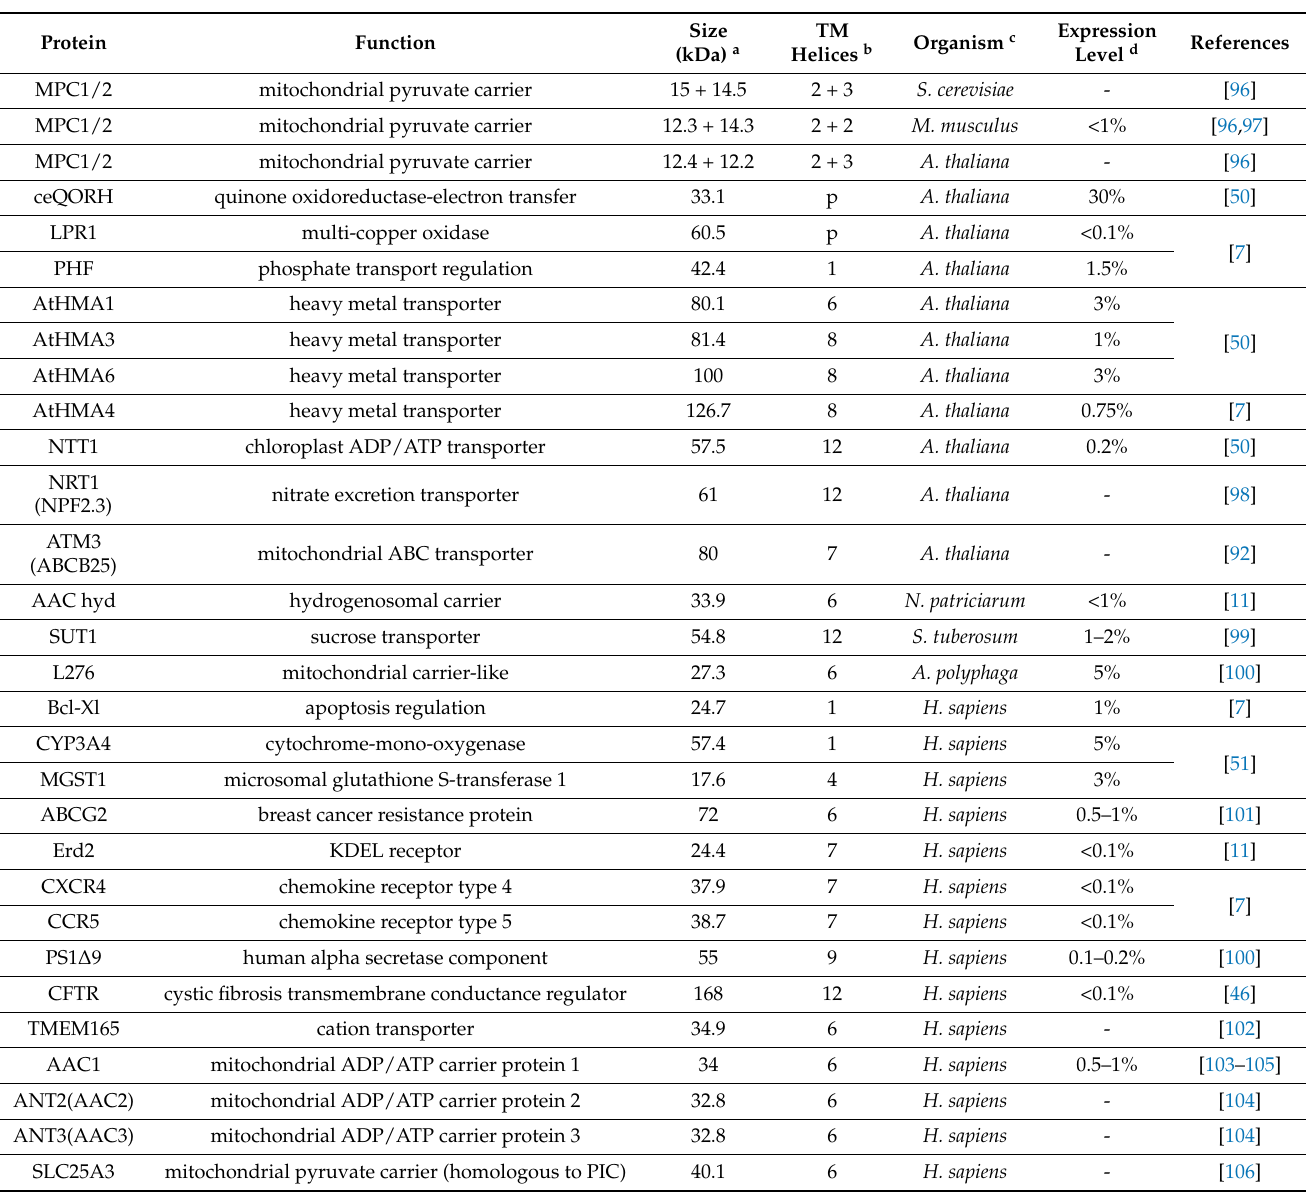
Tables 2–4: List of homologous and heterologous prokaryotic and eukaryotic